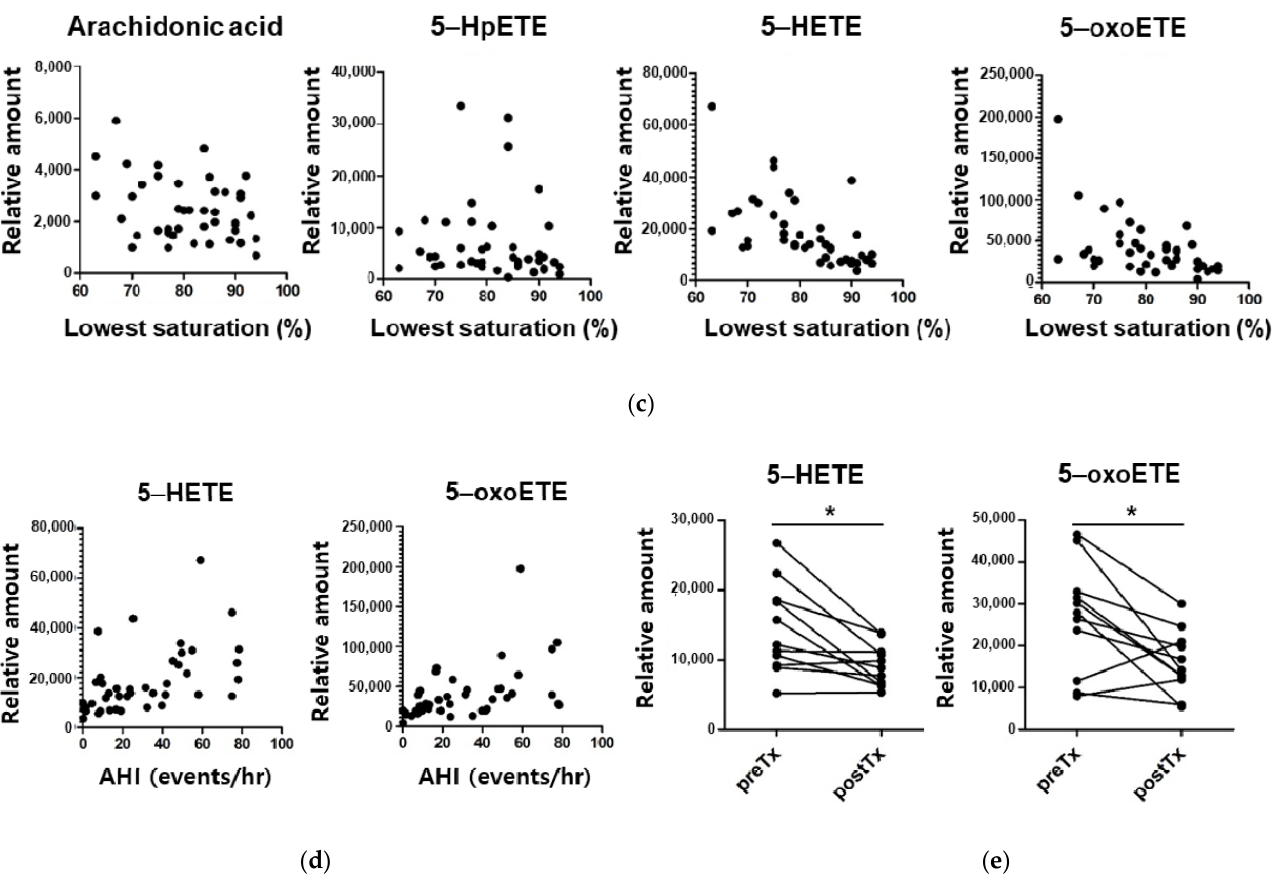
Figure 2. Levels of arachidonic acid derivatives in 5-lipoxygenase pathway and the association with the oxygen desaturation. ( a ) Arachidonic acid pathway and its derivatives through 5-lipoxygenae, glutathione peroxidase, and 5-hydroxyeicosanoid dehydrogenase. ( b ) Shown are the levels of arachidonic acid and its derivatives according to the severity of the obstructive sleep apnea syndrome—healthy control (apnea-hypopnea index [AHI] < 5), mild to moderate patients (5 ≤ AHI < 30), and severe patients (30 ≤ AHI). The horizontal lines indicate means, and I bars are standard deviations. ( c , d ) Correlation of arachidonic acid and its derivatives with the lowest oxygen saturation or with AHI. ( e ) Change of 5-HETE and 5-oxoETE in urine from the patients with the obstructive sleep apnea after the continuous positive airway pressure (CPAP) treatment. * and ** mean p < 0.05 and p < 0.01, respectively.